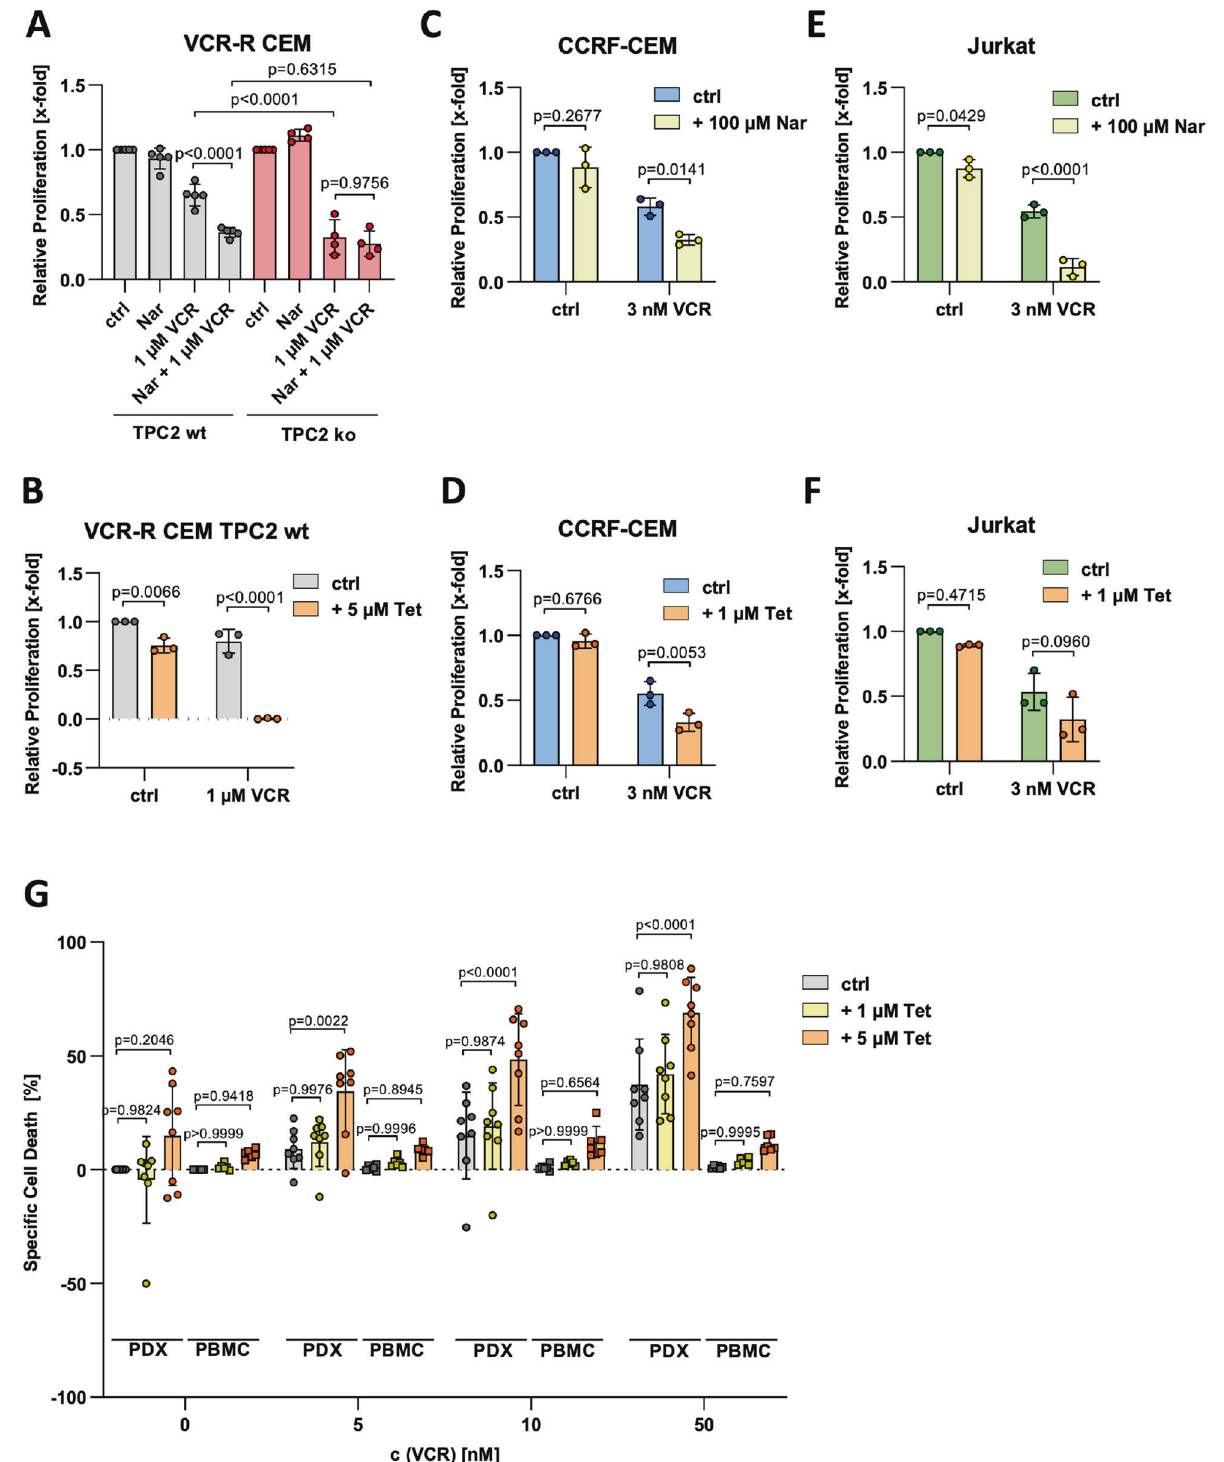
Fig. 3 Pharmacological TPC2 inhibition sensitizes leukemic cells to vincristine. VCR-R CEM TPC2 wt ( A , B ) and TPC2 ko ( A ), CCRF-CEM ( C , D ), and Jurkat ( E , F ) cells were treated for 72 h and relative proliferation was assessed by CellTiter-Blue assay. G Isolated patient-derived xenograft cells (PDX, n = 8; circles) and peripheral blood mononuclear cells (PBMC, n = 6; squares) were treated for 48 h and cell death was analyzed employing FSC/SSC plot by fl ow cytometry. Data were acquired from at least three independent experiments. Statistical signi fi cance was analyzed by two-way ANOVA with Tukey ’ s posttest ( A , G ) or Sidak ’ s posttest ( B – F ). Data are shown as mean ±